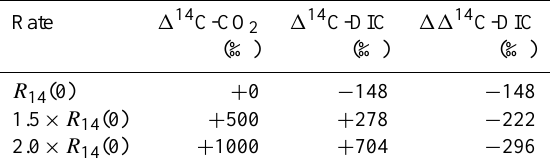
Table C2. Effect of radiocarbon production rate on atmospheric and marine 14 C values under steady-state conditions. R 14 (0) is the